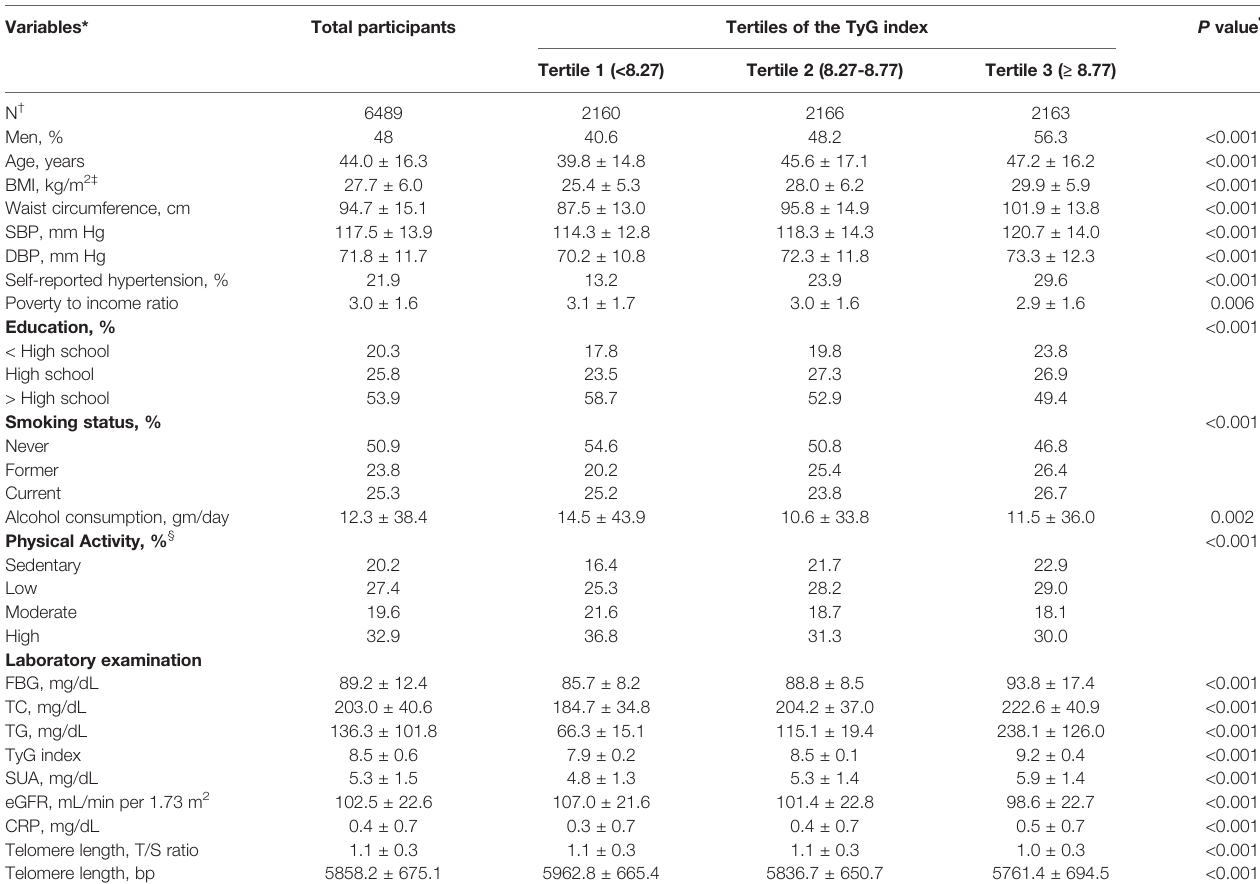
TABLE 1 | Weighted characteristics of study population according to tertiles of the TyG index. Variables* Total participants Tertiles of the TyG